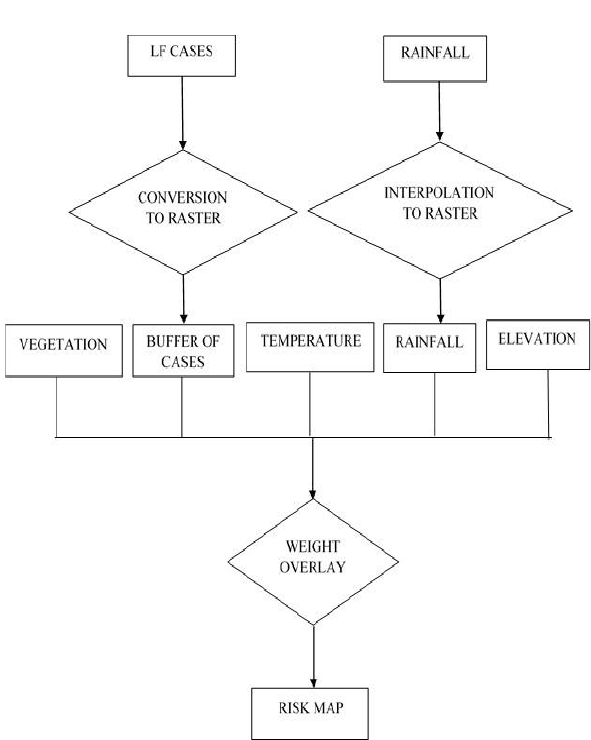
Figure 2. Chart showing the overview of project